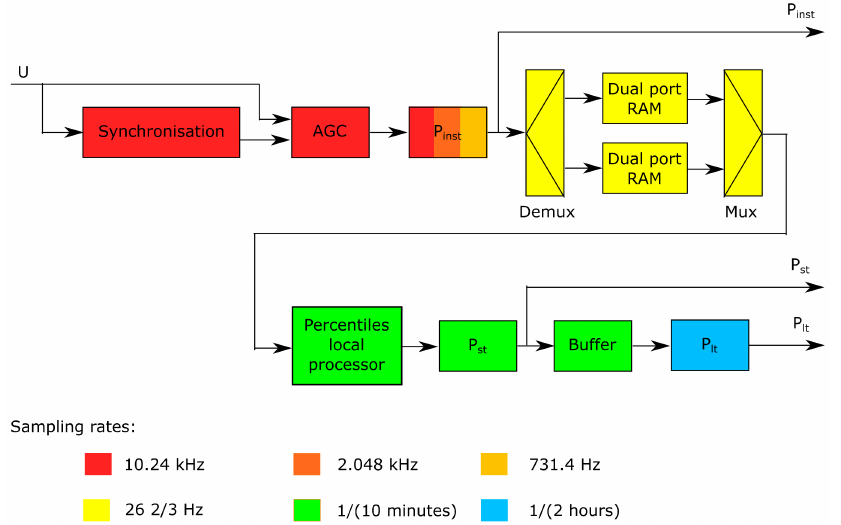
Figure 4. Dataflow of the flickermeter